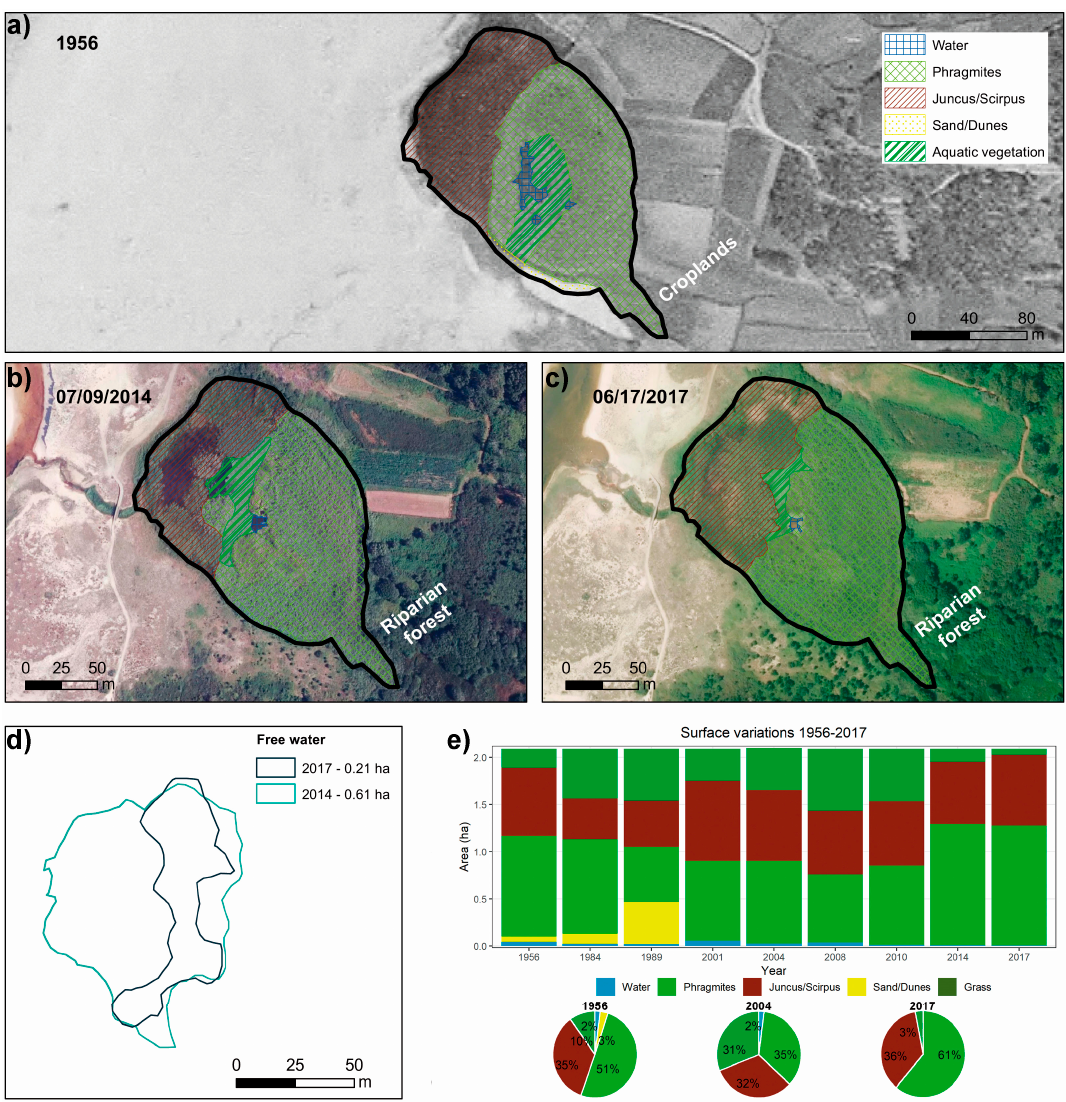
Figure 3. Cartography and data of the Xuño lagoon. ( a ), ( b ), and ( c ) represent the areas covered by each category in 1956, 2004, 2014, and 2017, based on the aerial images taken each year (IGN). ( d ) shows variations in the water-covered area between 2014 and 2017, and ( e ) shows the area (in ha) covered by each category in the different dates, as well as the percentage they represented relative to the total area of the